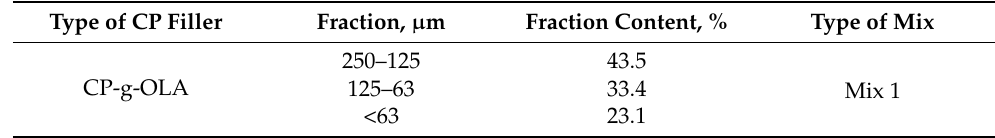
Table 3. Fraction proportions of grinded CP filler after the modification (Mix